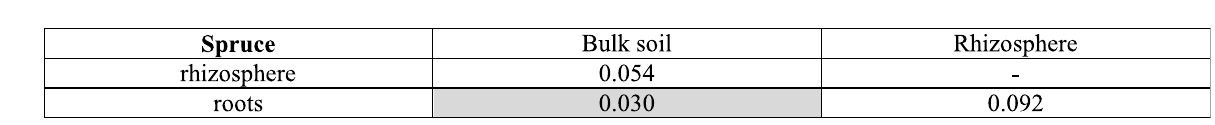
Light blue indicates p value ≤ 0.01, and light gray, p value ≤